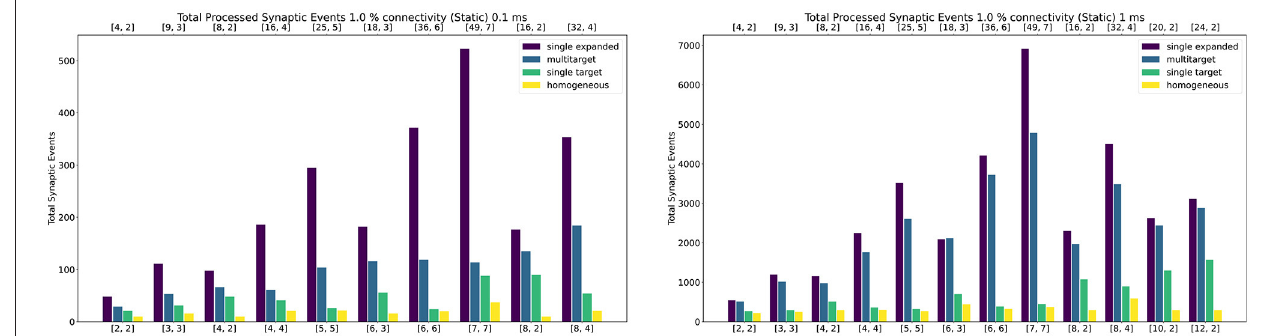
FIGURE 10 | Peak processed synaptic events per timestep. The presented configuration represents a 1% connectivity static network. Both 0.1 ms (left) and 1 ms (right) cases are shown. Each plot contains the results for the Single target expanded (purple), multi-target (blue), single target (green) and baseline homogeneous partitioning (yellow) cases. The horizontal axes show the number of cores per ensemble in the form of [ S c , N c ], as indicated in Section 4.2.1 and Figure 9 . The top axis refers to the single target expanded case (purple), the bottom to the other cases.